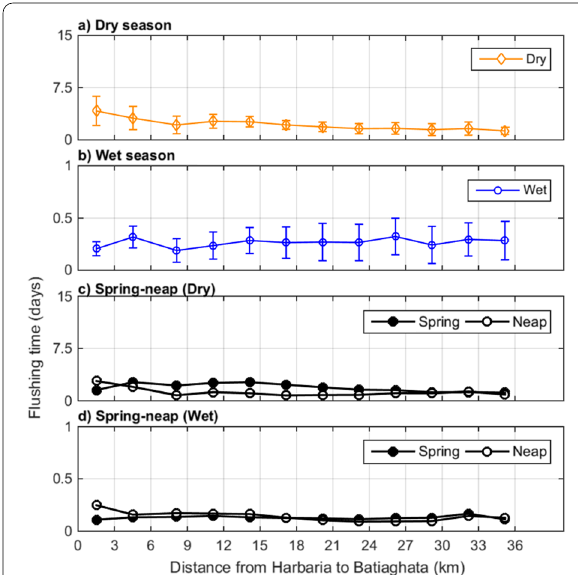
Fig. 7 Spatio‑temporal variation of flushing time calculated using freshwater fraction method (FFM) for multiple estuarine segments of the Pasur River Estuary during spring and neap tides in the dry and wet seasons